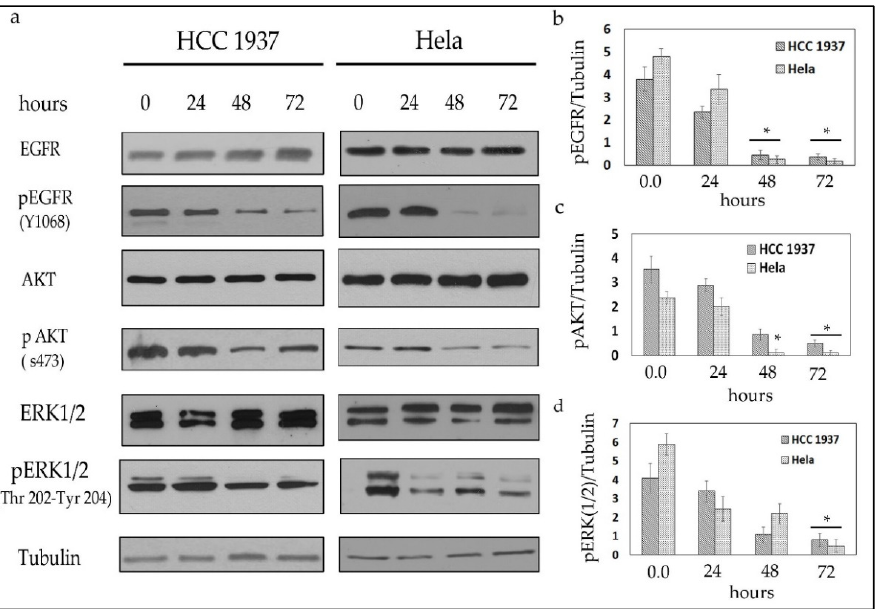
Figure 2. Compound 1 inhibits EGFR signaling in HCC1937 and HeLa cancer cells. ( a ) Western blot- Table 1. at 7 and 11 µM for 24, 48 and 72 h and analyzed with antibodies to EGFR, pEGFR, AKT, pAKT, ERK1/2, and pERK1/2, respectively. Tubulin was used as a loading control. ( b – d ) Graphs representing densitometric quantitation of the magnitude of proteins in ( a ), the asterisk signifies statistical significance by one-sided Student’s t-test ( p < 0.05).